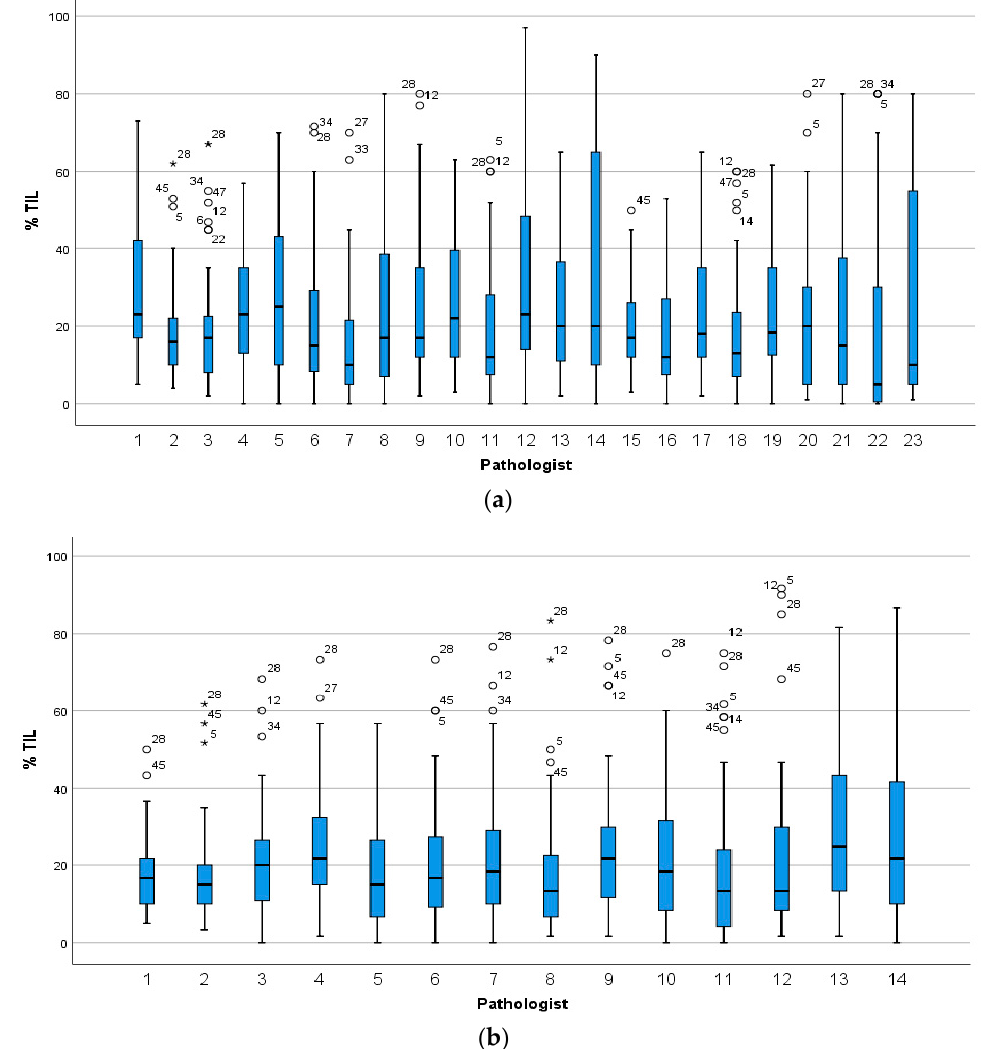
Figure 1. The distribution of sTILs scores for the 49 cases given by ( a ) 23 pathologists in circulation 1 and ( b ) the 14 pathologists in circulation 2. Pathologists are numbered on the x-axis and those who completed both circulations are assigned the same number in circulation 1 and 2. Stars and circles are outliers which lie abnormally far from the other values in the dataset. A circle denotes a value which is either greater than 3rd quartile plus 1.5× interquartile range or is less than 1st quartile minus 1.5× interquartile range. A star denotes an extreme outlier value, which is either greater than 3rd quartile plus 3× interquartile range or is less than 1st quartile minus 3× interquartile range. The number beside the stars and circles is the TNBC slide and case number for that outlier. There was more variation in scoring when each pathologist selected the tumour area to score ( a ) compared to when each pathologist scored the same FOV ( b ). As observed in the heat map, the scores from two pathologists (number 7 and 20) diverged from those of others in circulation 1 but appeared somewhat similar to each other (Figure 2a). However, the pattern of scoring by pathologist 7 aligned more closely with that of the group in circulation 2 (Figure 2b) than it did in circulation 1 (Figure 2a). This change in scoring pattern by pathologist 7 between the two circulations was also re- flected in a negligible agreement between this pathologist’s scores in the two circulations (Spearman ρ for absolute value = 0.156, p = 0.290). In circulation 2, the scoring by pathologists 4 and 13 was observed to be similar and diverged from that of others (Figure 2b). There was no zone within which inter-observer agreement was worst or best or a cutpoint, above or below which all pathologists assigned all cases in the same category, but there appeared to be fewer outlier scores above a threshold of 30% in both circulations (Figure 2). Examination of the scoring patterns between pathologists at FOV-level similarly showed that the scoring by a small number of pathologists (numbers 13 and 14) deviated from that of others (Figure S1).